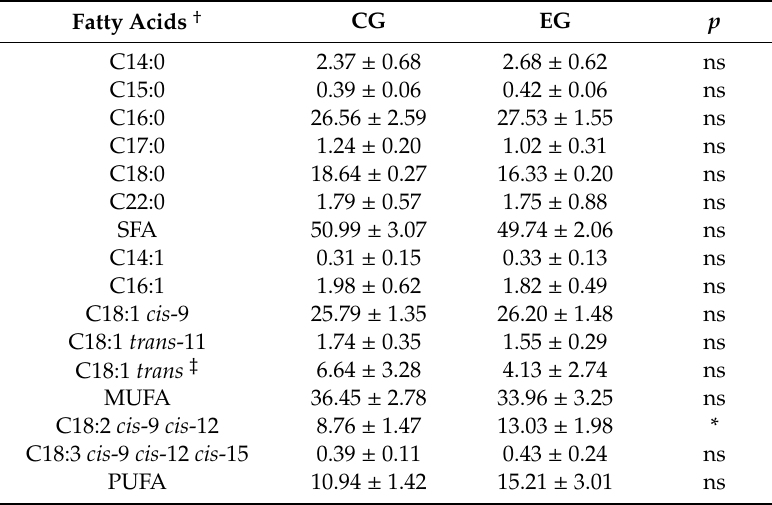
Table 4. Fatty acid profile of meat samples obtained from animals fed a standard diet (CG) and animals fed a dietary supplementation of 10% dried grape pomace